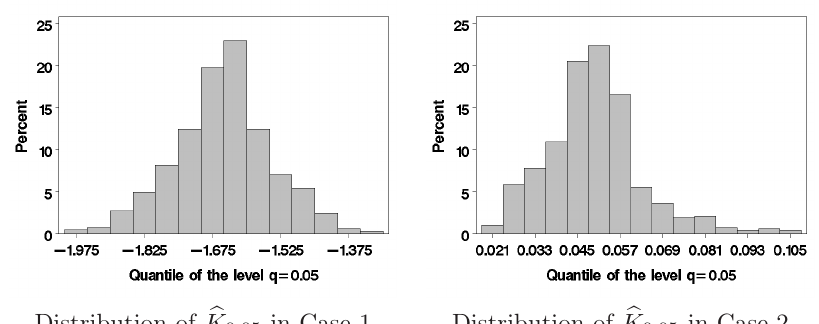
1000 simple random samples of size n = 200 have been drawn from a finite population. Given a sample drawn without replacement from a finite popula- tion, B = 1000 bootstrap samples are drawn of size m = 200 with replacement from the original sample in the cases TB and RB. Parameters for which we estimate confidence intervals by different methods are quantiles of the levels q equal to 0.05, 0.25, 0.50, 0.75 and 0.95. The distribution of the quantile estimators are presented in Fig. 3 and Fig. 4.